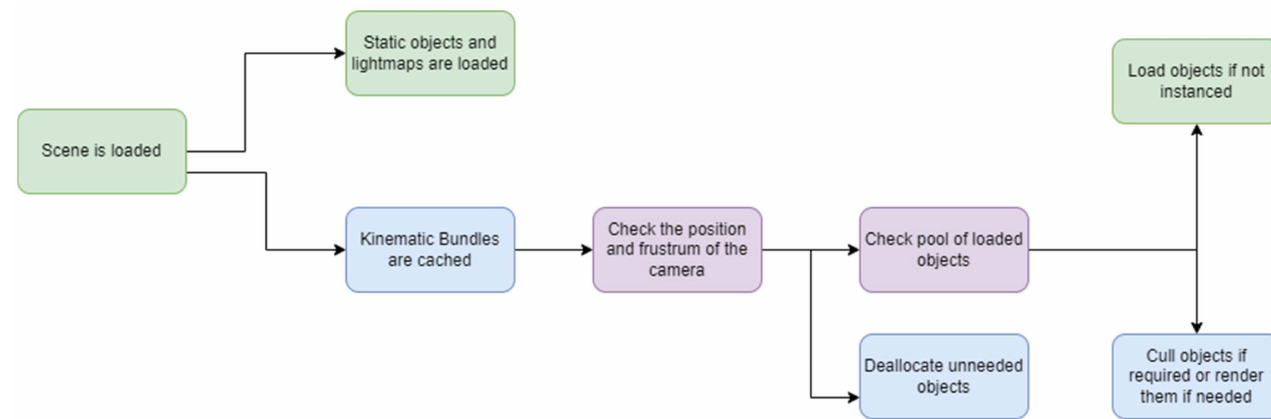
Figure 3. Bundle